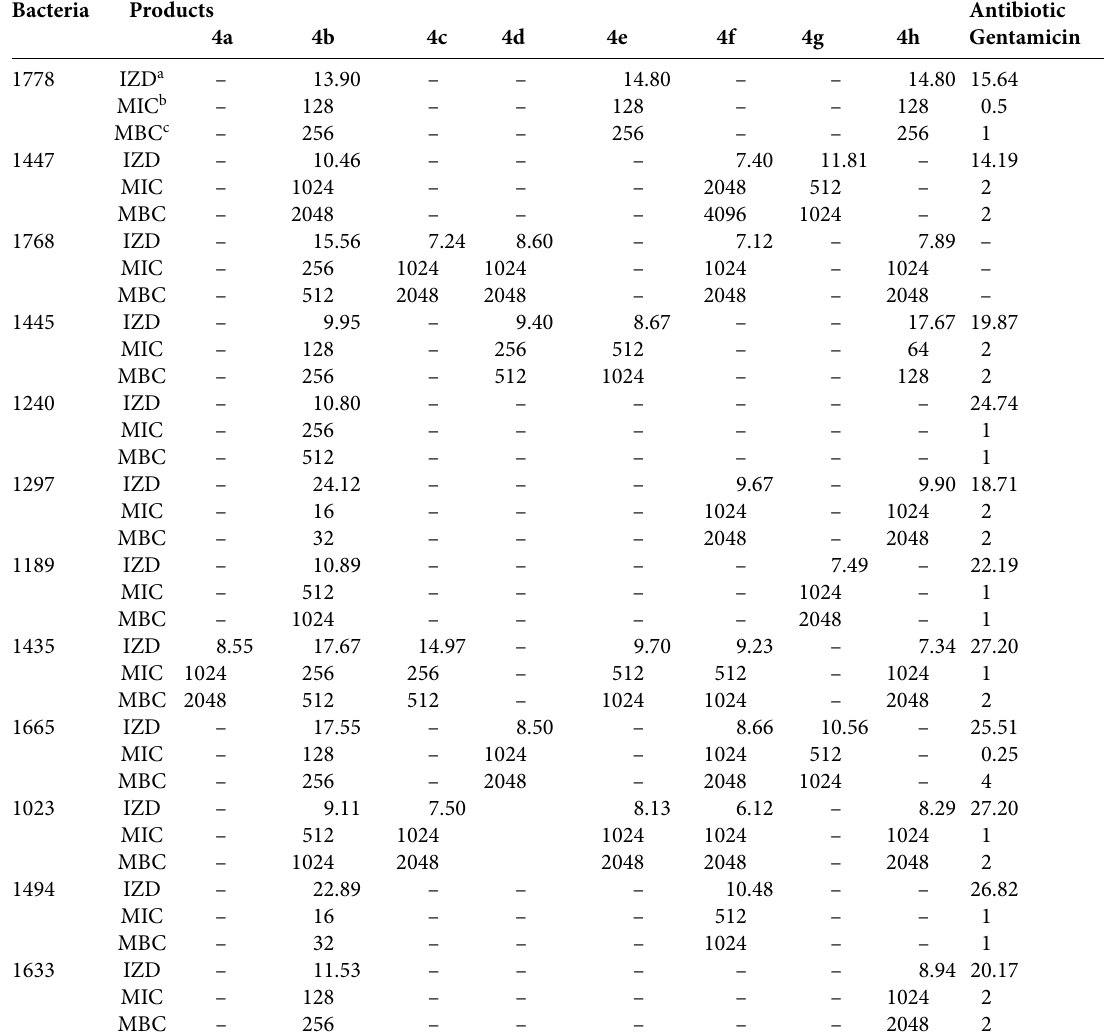
Table 3. Inhibitory activities of thioethers 4a–h against Gram–positive pathogenic bacteria.